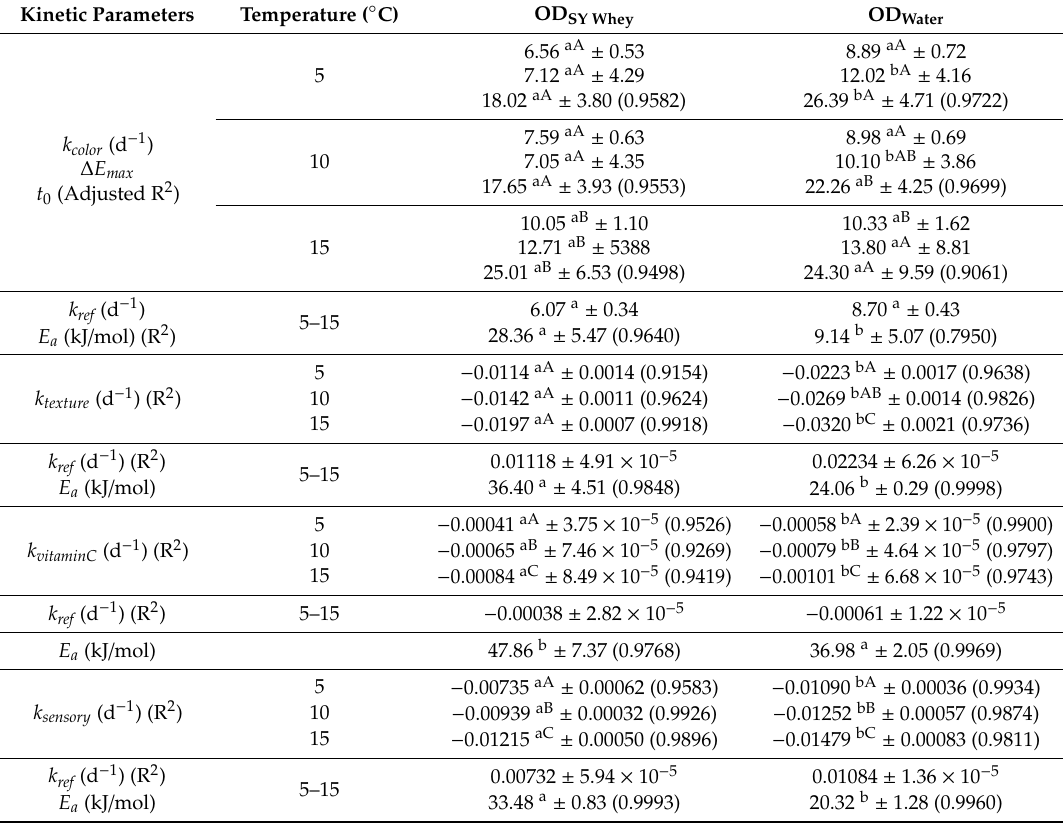
Figure 2. ( a ) Total color change ( Δ Ε ) by instrumentally measured color parameters L , a , and b , ( b ) texture measured as maximum force (hardness, F max , N), ( c ) scores for total sensory quality (scale 1–9), and ( d )% vitamin C loss of pumpkin cuts in solution of strained yoghurt whey or water (Index 1: OD SY Whey and Index 2: OD Water ). Experimental points correspond to isothermal temperature conditions ( ) 5 °C, ( ) 10 °C, ( ) 15 °C; lines represent the respective model fit. Table 3. Estimated kinetic parameters ( k color , k texture , k vitaminC , k sensory ; E a , k ref at T ref = 4 °C) used for quality deterioration of OD processed pumpkin cuts at 55 °C for 120 min (OD SY Whey and OD Water ), and stored at isothermal temperature (5, 10, 15 °C) conditions based on instrumental measurement of color and texture, vitamin C, and organoleptically perceived quality (sensory).